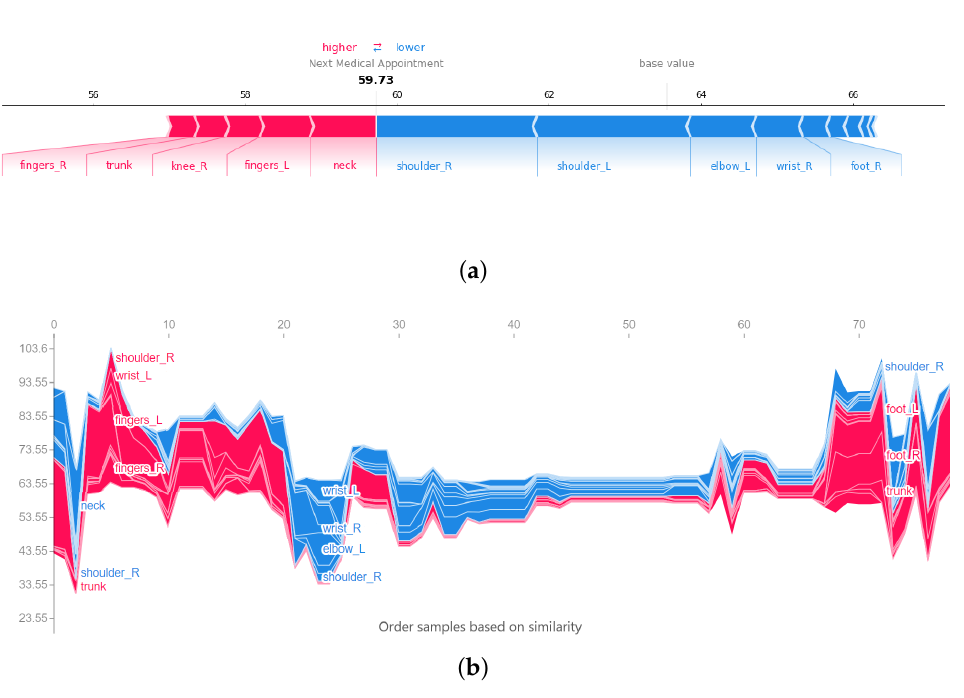
Figure 7. Force plot for ( a ) one record where the variables that increase the prediction of the model the most are shown in red and those that reduce the prediction of the model the most in blue. The numbers in the black line represent the number of weeks infected workers per body parts according to the base value of the training set (66) and the output value of the model’s prediction (59.73) for a sample record and ( b ) all records sorted by similarity. By a 90-degree rotation of the y-axis at a single point on the x-axis, the ( a ) sub-plot will be